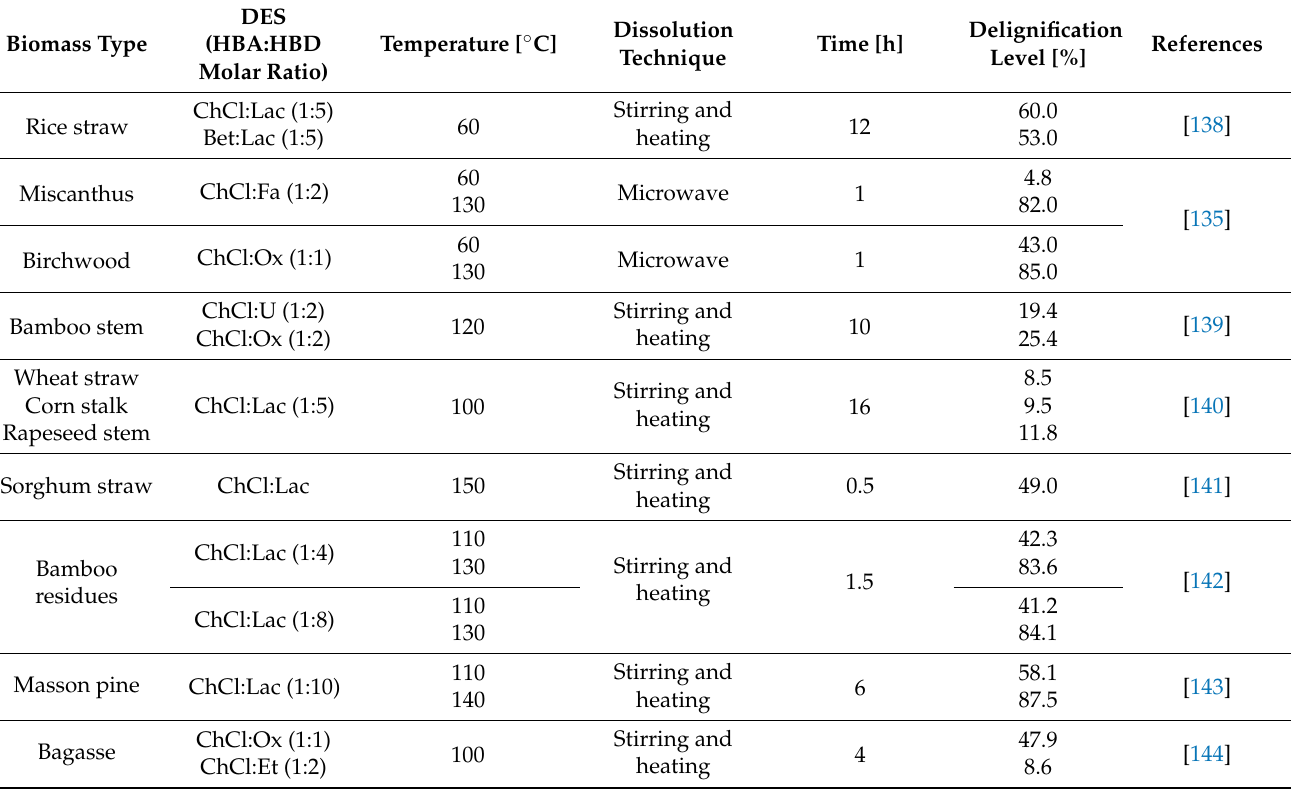
Table 4. Delignification of plant biomass with